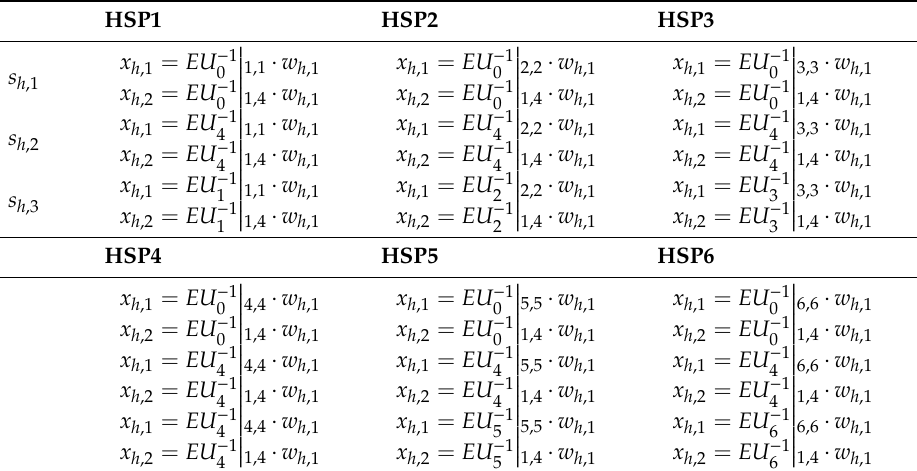
Table 4. Hot backup gate SHA with the continuous variable motion law Γ h